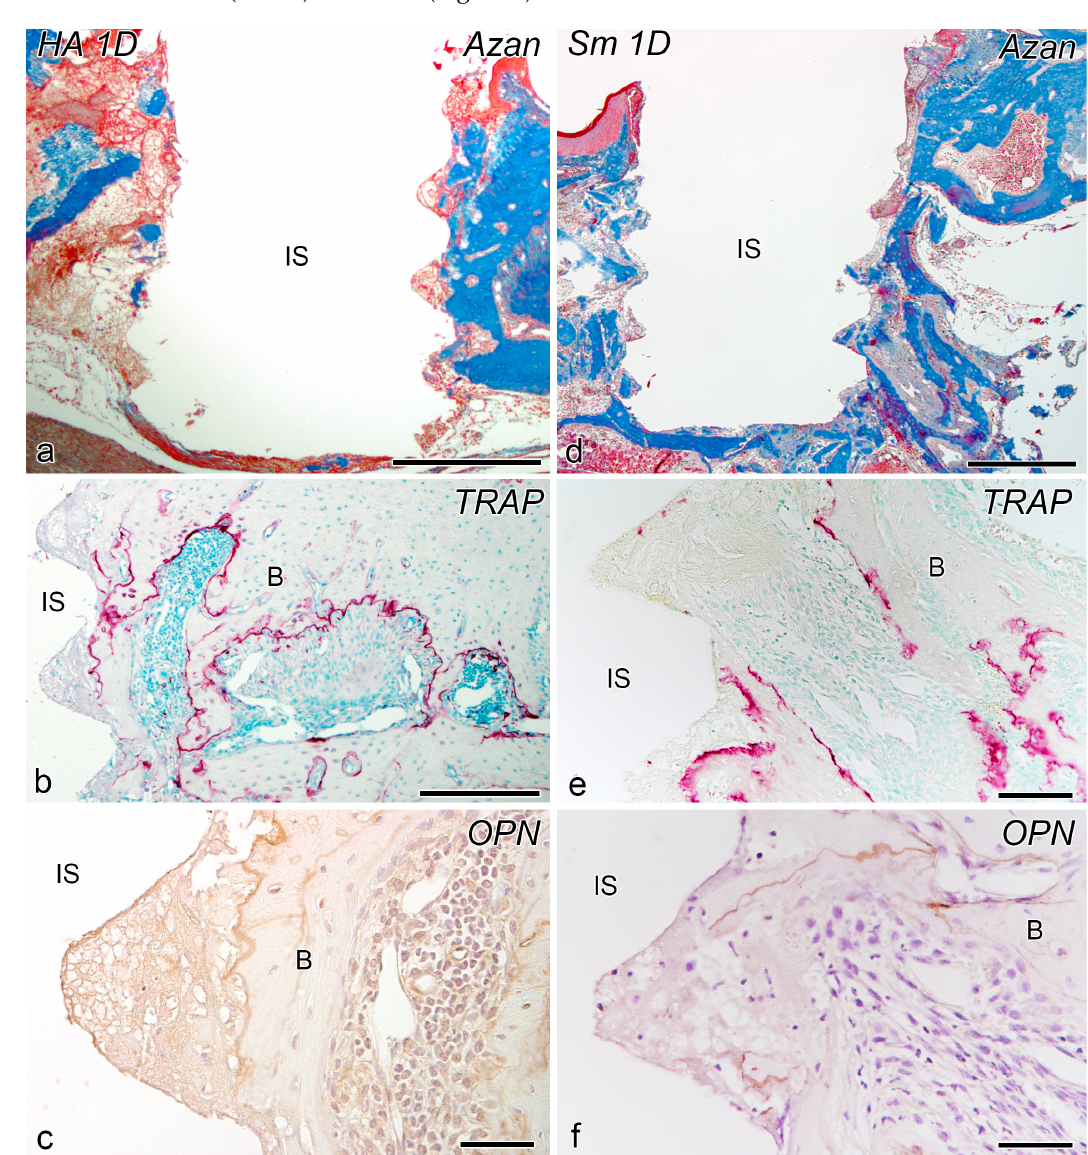
Figure 1. Azan staining ( a , d ), tartrate-resistant acid phosphatase (TRAP) reaction ( b , e ), and osteo- pontin (OPN)-immunoreactivity ( c , f ) in the tissues surrounding the implants in the blasted (HA) ( a – c ) and non-blasted (Sm) groups ( d – f ) at day 1 after implantation. ( a – f ) The bone-implant interface consists of a fibrin network and inflammatory cellular infiltrate, while the preexisting bone surface is positive for TRAP and OPN. B, bone; IS, implant space. Scale bars = ( a , d ) 500 μ m, ( b ) 250 μ m, ( e ) 100 μ m, and ( c , f ) 50 μ m.